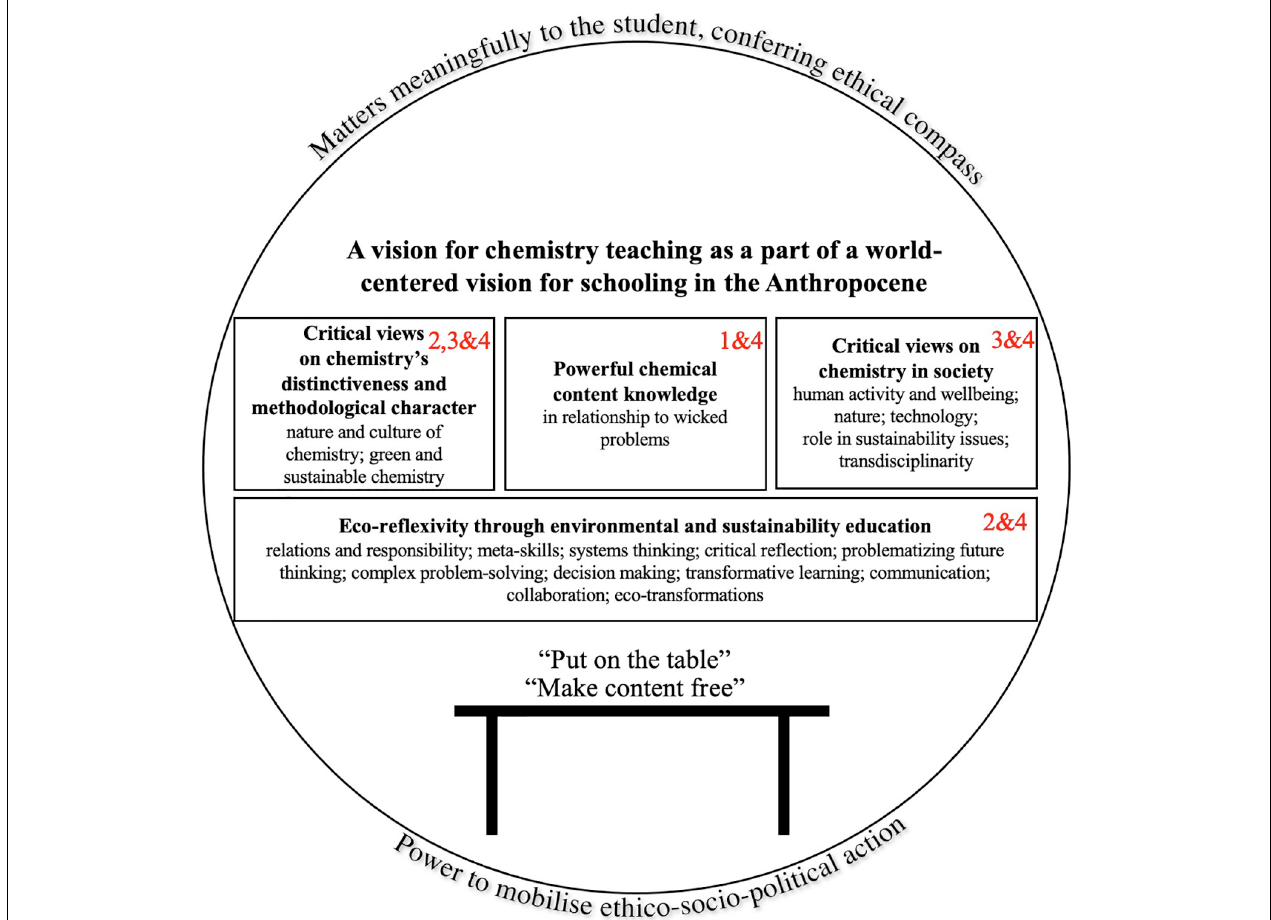
FIGURE 4 | A vision-oriented didaktik model for promoting ChemoKnowings and “chemical agency” in chemistry teaching. It includes the teacher’s consideration of student transformation of content. Note that the numbers in red indicate connection to Hodson’s (2003) four elements of the science curriculum: (1) learning relevant chemistry concepts; (2) doing chemistry (in a broad sense); (3) critical contextualisation of chemistry; and (4) chemical agency, including relational and embodied